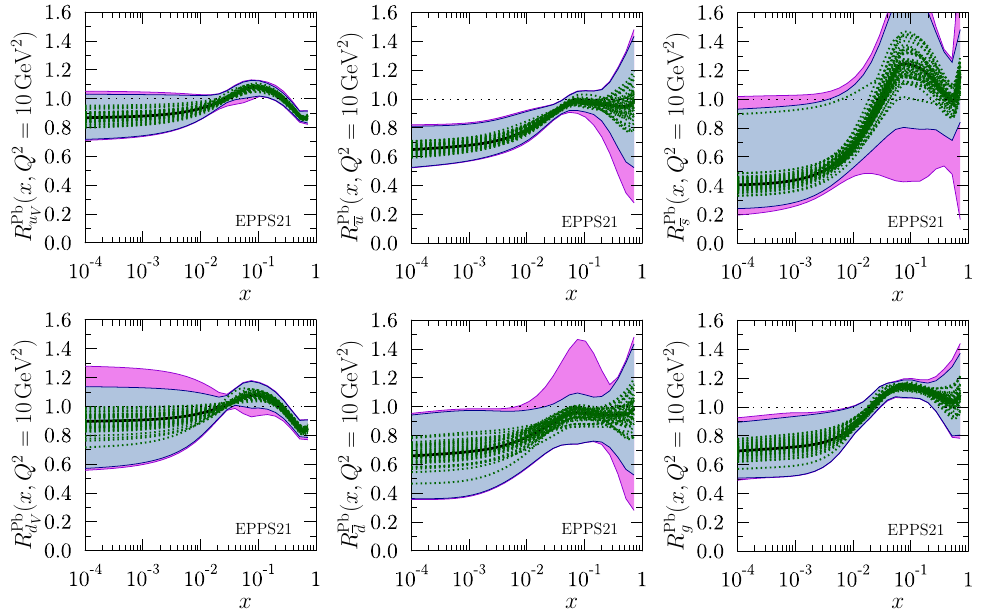
Figure 4: The preliminary EPPS21 nuclear modifications in lead at the 10 GeV 2 scale. The blue and purple bands show the nuclear and full errors, respectively, in accor- dance with Figure 1, and the black solid line and green dotted lines show the results for the central and nuclear error sets,